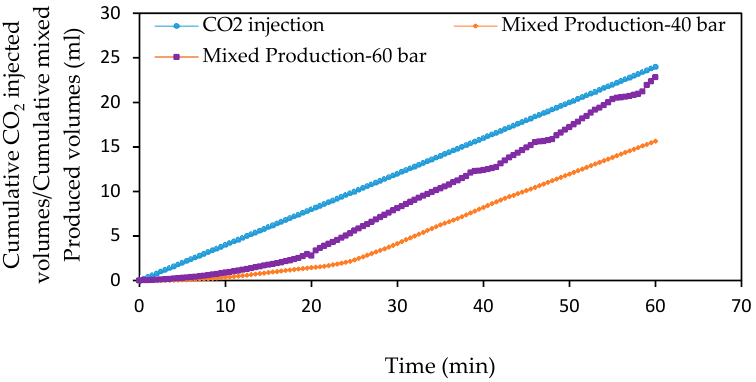
Figure 17. Effect of fluid pressure on the cumulative produced volumes of oil and CO 2 for low-fluid-pressure GCO 2 –oil displacements conducted at 33 °C and 0.4 mL/min.